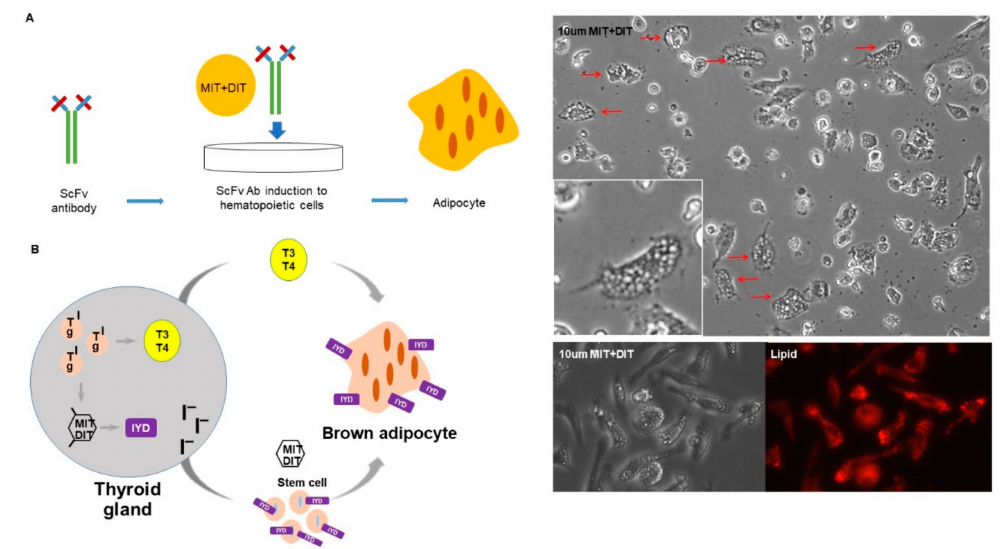
Figure 6. MIT and DIT induced stem cell di ff erentiation into brown adipocyte-like cells. ( A ) The hematopoietic stem cell di ff erentiation by IYD substrate (MIT + DIT): In the presence of IYD substrate for 2 weeks, human CD34 + cells di ff erentiated into adipocyte-like cells as measured by lipid staining. Red arrows indicate adipocyte-like cells. (Magnification: 20 × ). ( B ) Proposed scheme for the dual role of IYD as a catalyst in thyroid cells and as a receptor for cooperative stem cell di ff erentiation: IYD scavenges iodine and, in the presence of the MIT / DIT substrate, catalyzes the production of Triiodothyronine (T3) and Thyroxine (T4) thyroid hormones. T3 and T4 signaling can then lead to increased brown adipogenesis. IYD-expressing stem cells function as a receptor for H3 Ab or MIT / DIT to bind and induce di ff erentiation of the stem cell into brown